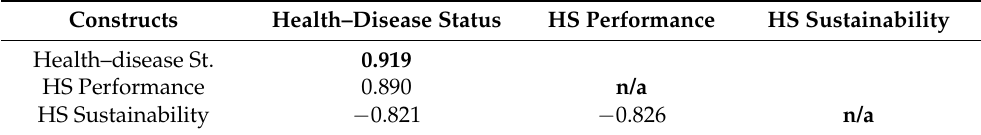
Table 7. Fornell and Larcker criterion